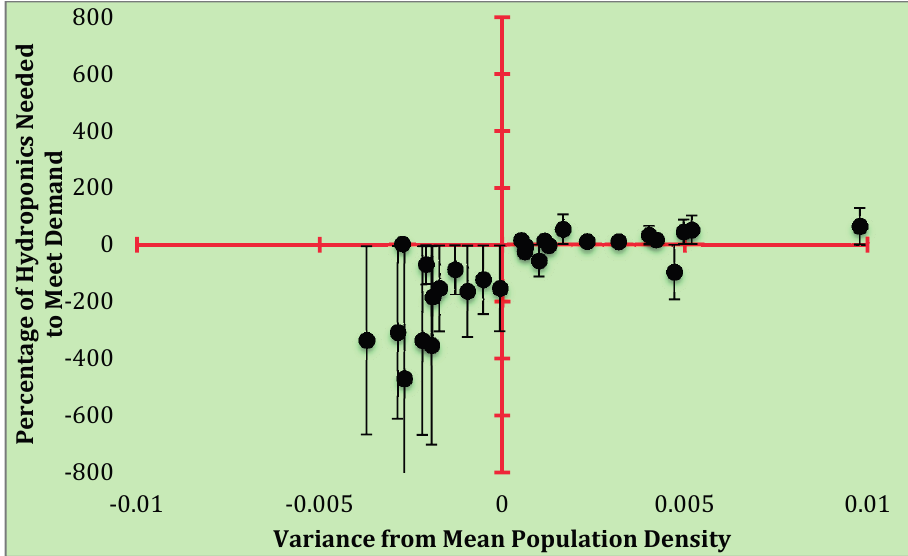
Figure 4. Performance indicator of each borough comparing hydroponic needs against relative population density, assuming average yield values (mean of high- and low-intensity yield estimates). Error bars show the variance in the need for hydroponics as farm management and yield values becomes more or less intense. Five outlier boroughs were excluded for visual